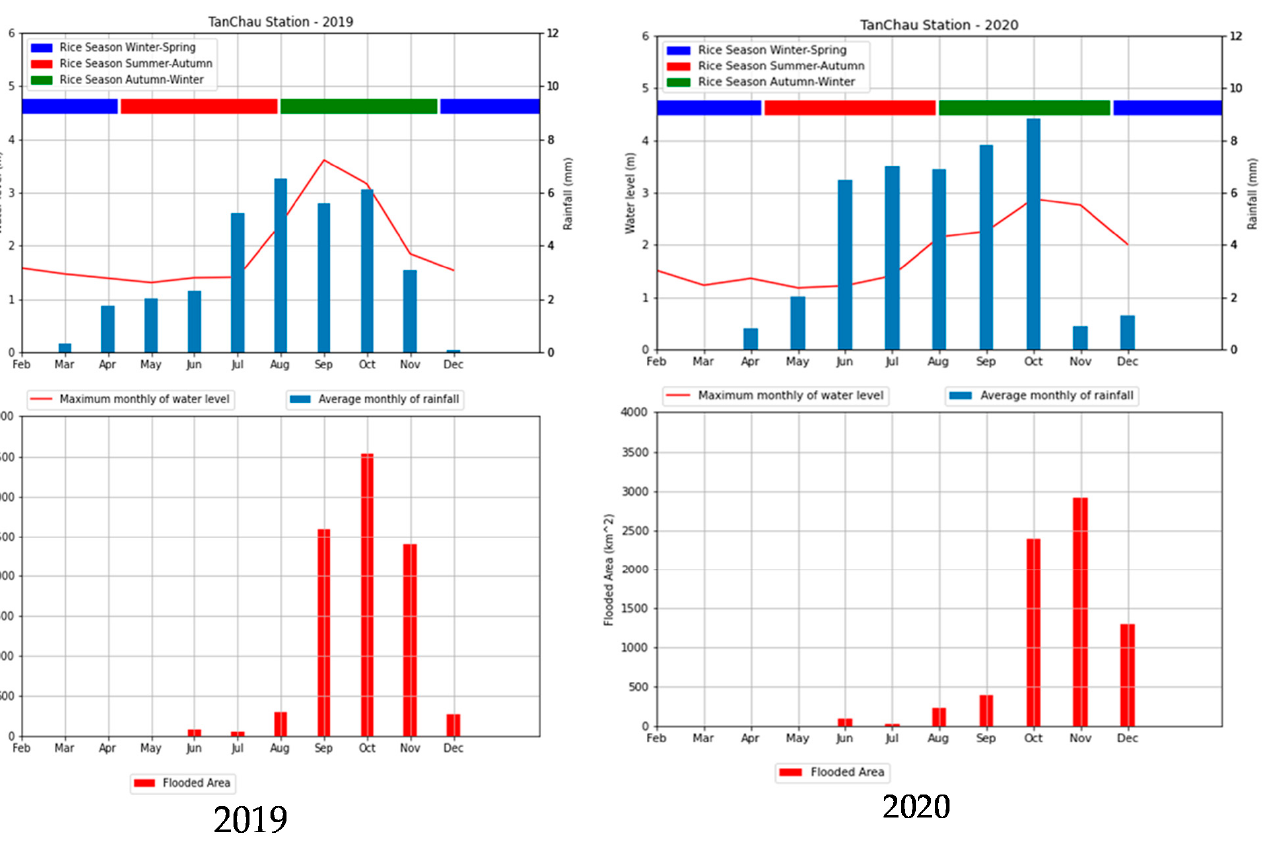
Figure 10. Average monthly rainfall; Maximum monthly water levels and flooded area in km 2 for 2019 and 2020.